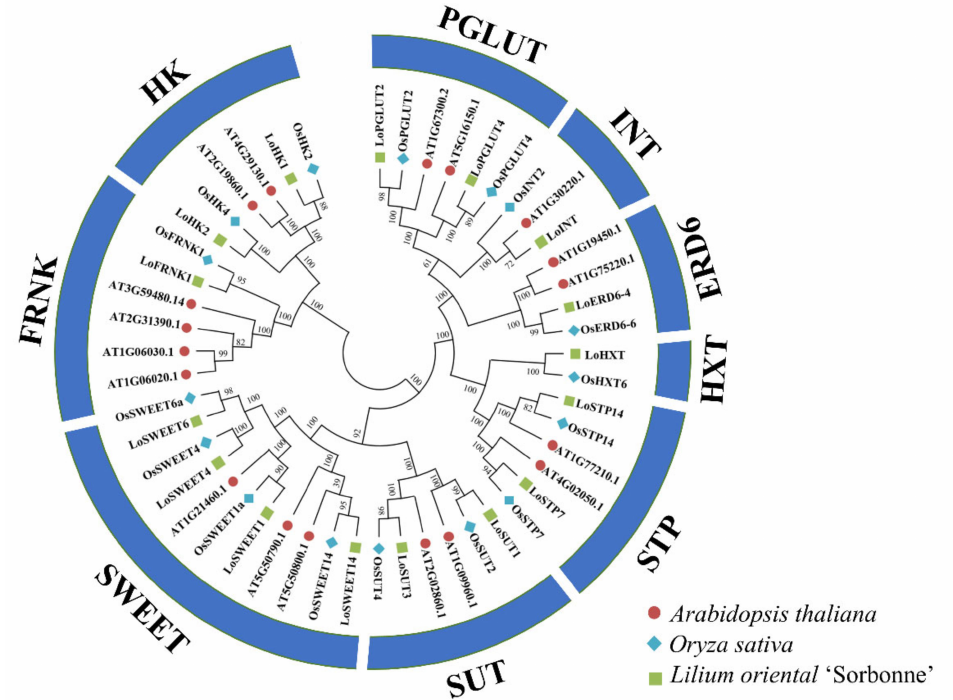
Figure 2. The phylogenetic relationship of ST genes in Arabidopsis (red), rice (blue) and lily